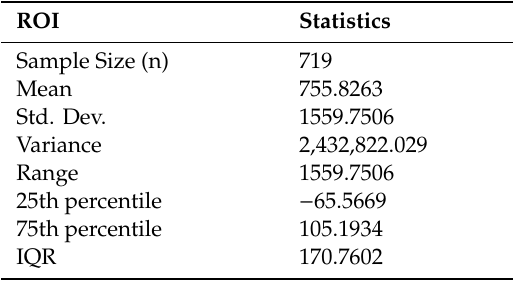
Table 3. Summary Statistics for ROI during Years 2010–2015. Unit is Percent